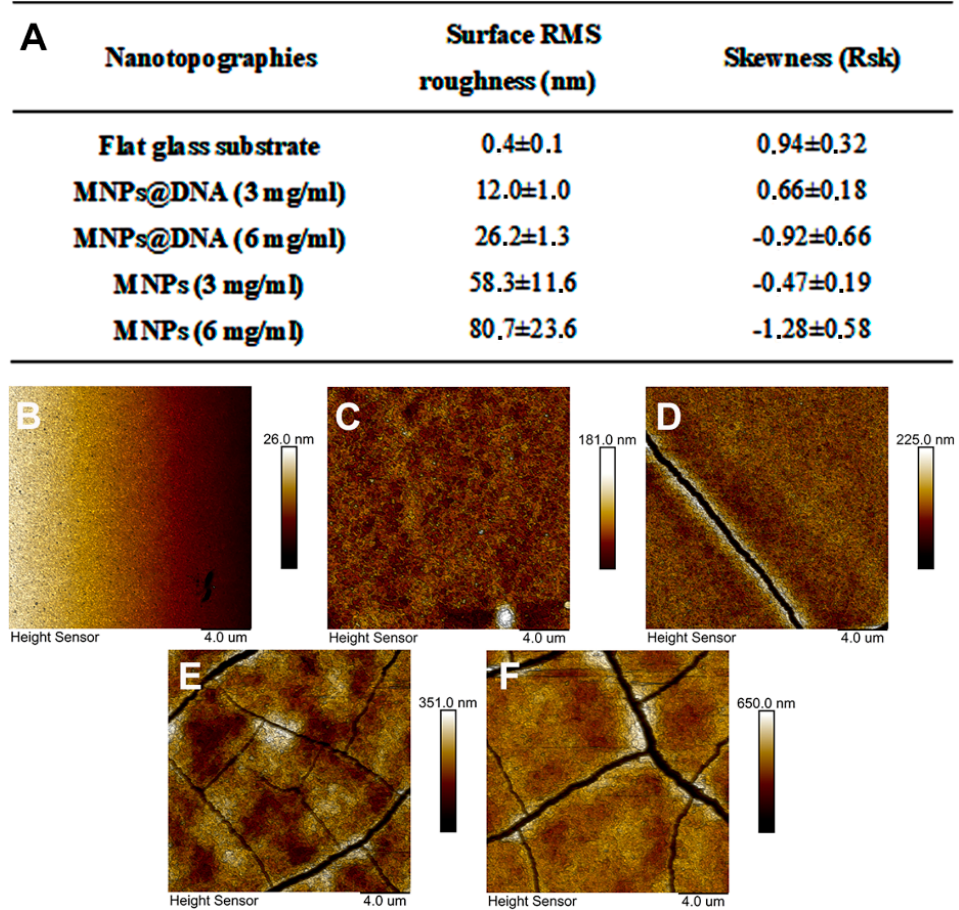
Figure 3. ( A ) Surface RMS roughness and their asymmetry coefficient obtained with AFM. AFM surface topography: ( B ) glass, ( C ) MNPs@DNA 3 mg/mL, ( D ) MNPs@DNA 6 mg/mL, ( E ) MNPs 3 mg/mL, ( F ) MNPs 6 mg/mL.